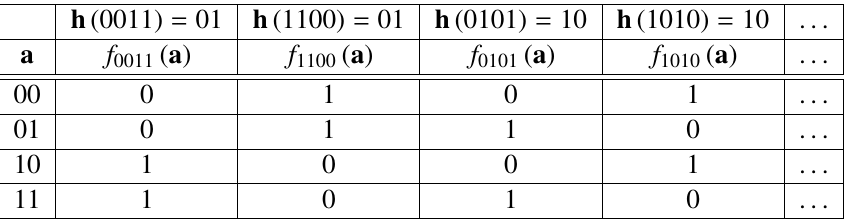
Table 3: Tabular representation of the functions f b ( a ) that are evaluated by the black box in the Simon’s